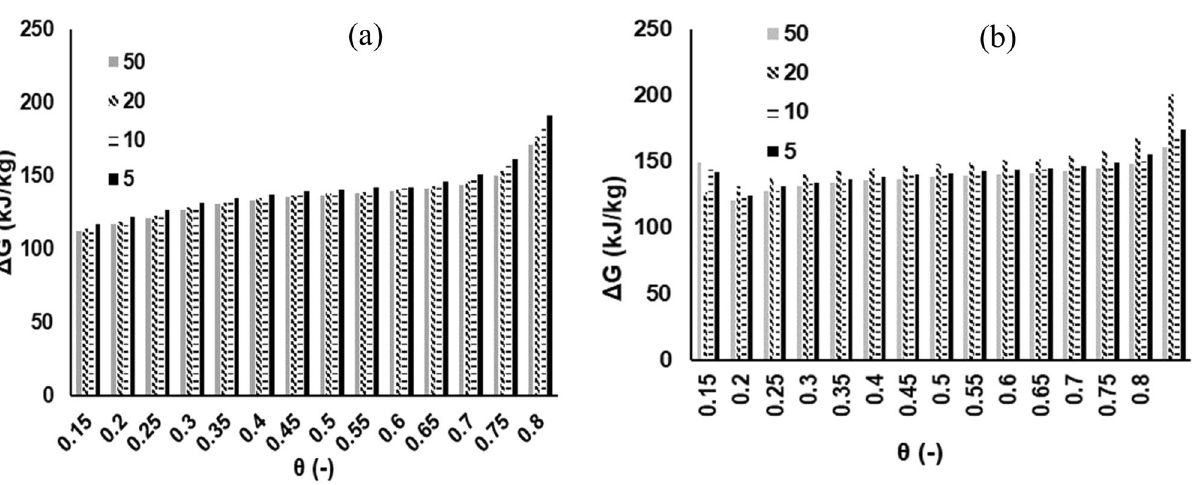
Figure 8. Plot of change of Gibbs free energy ( (cid:31) G ) at 5, 10, 20, 50 K/min based on DFM (N 2 pyrolytic environment) for ( a ) MH and ( b ) RP thermal